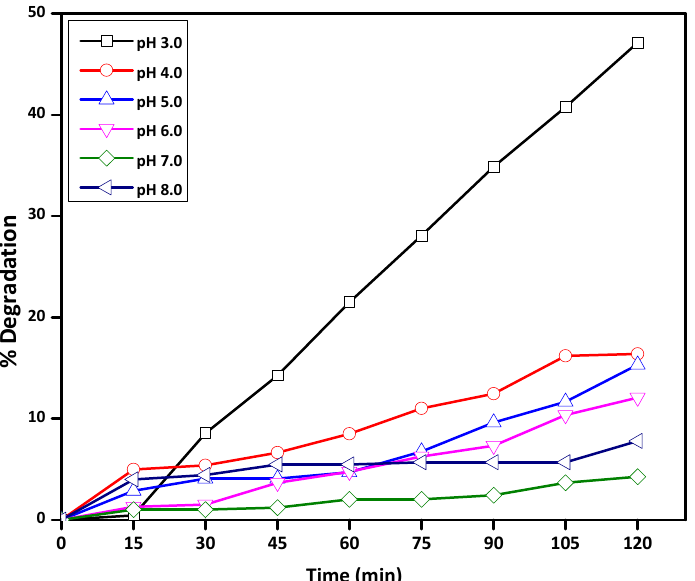
Figure 2. Degradation of ANB at different initial solution pH (FFGN = 0.5 g/L, ANB = 50 ppm, Amplitude = 40%, Probe = 25 mm, T = 25 ± 1 °C).